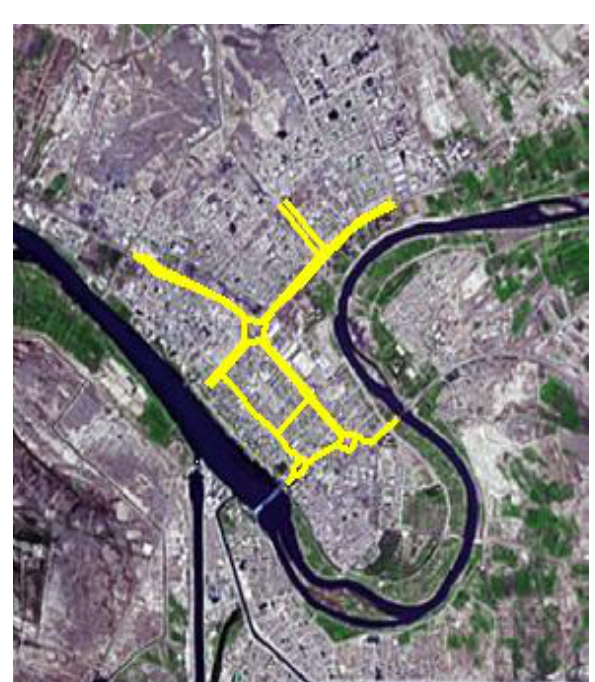
Fig.10: Producing the network of roads from low resolution image at scale